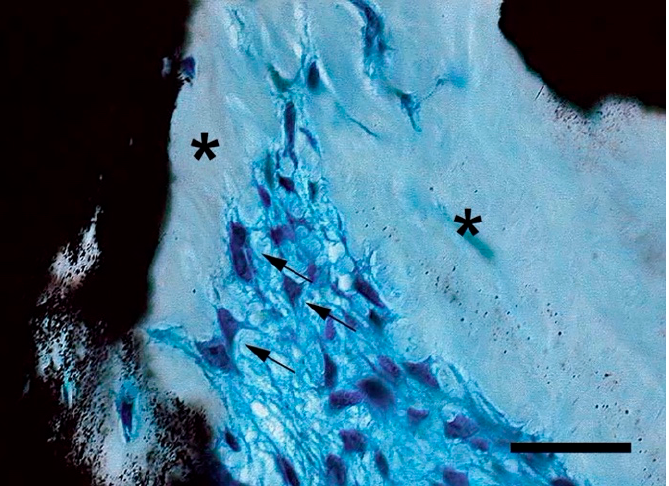
Figure 3. Abnormally shaped (i.e., retracted, arrows) osteoblasts and excessive unmineralized bone matrix (asterisks) in Fibrous Dysplasia (FD) bone. Formalin-fixed undecalcified plastic-em- bedded sample, Von Kossa-Methylene Blue. Bar: 50